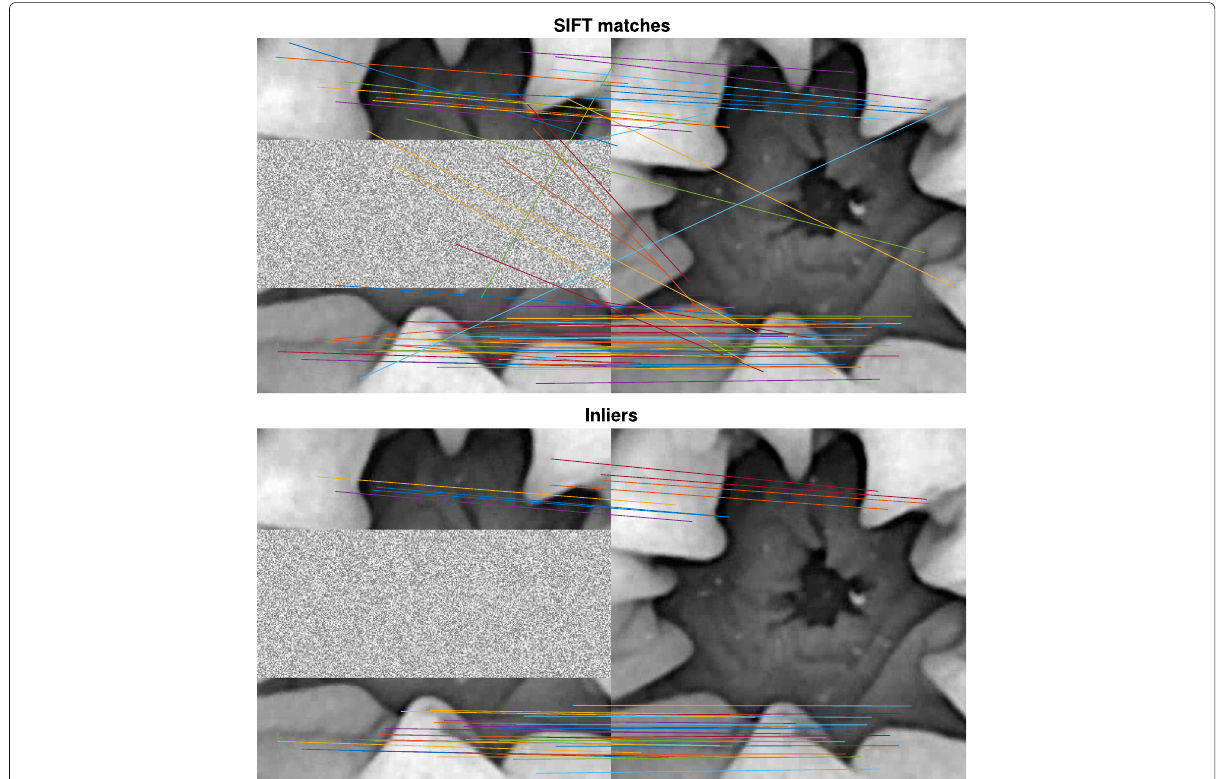
Fig. 6 Estimating H for a highly corrupted frame. Upper: Matching SIFT features. Lower: inliers after RANSAC